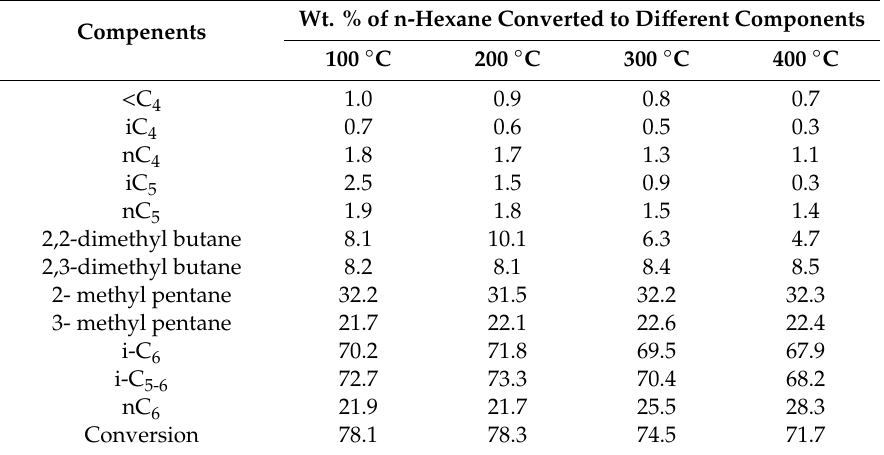
Table 2. The product distribution of 10 wt% NiP / H β calcined at di ff erent temperatures.